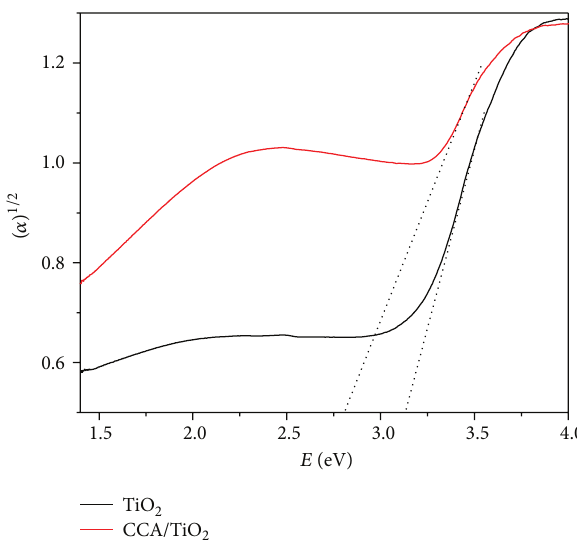
Figure 4: Band-gap studies of TiO 2 and CCA/TiO 2